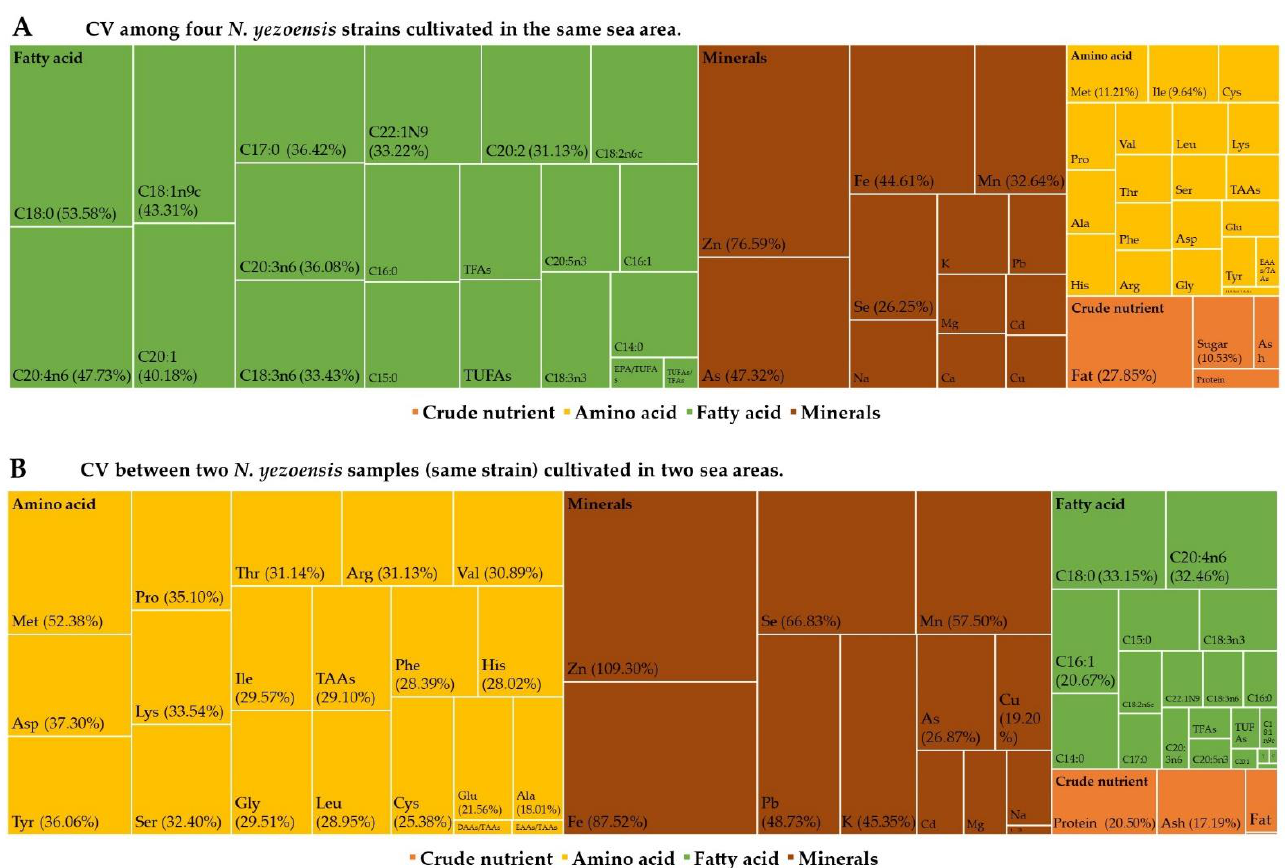
Figure 4. Treemap of coefficient of variation (CV) of crude nutrient, amino acid, fatty acid, and minerals among the four N. yezoensis strains cultivated in the same sea area ( A ) and between two N. yezoensis samples (same strain) cultivated in two sea areas ( B ).